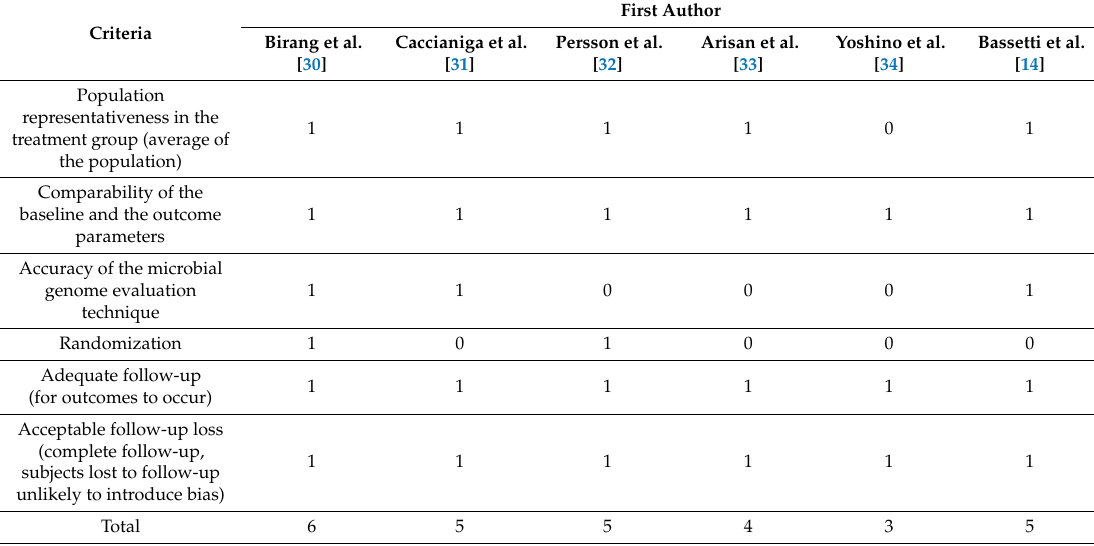
Table 2. Quality assessment of studies.